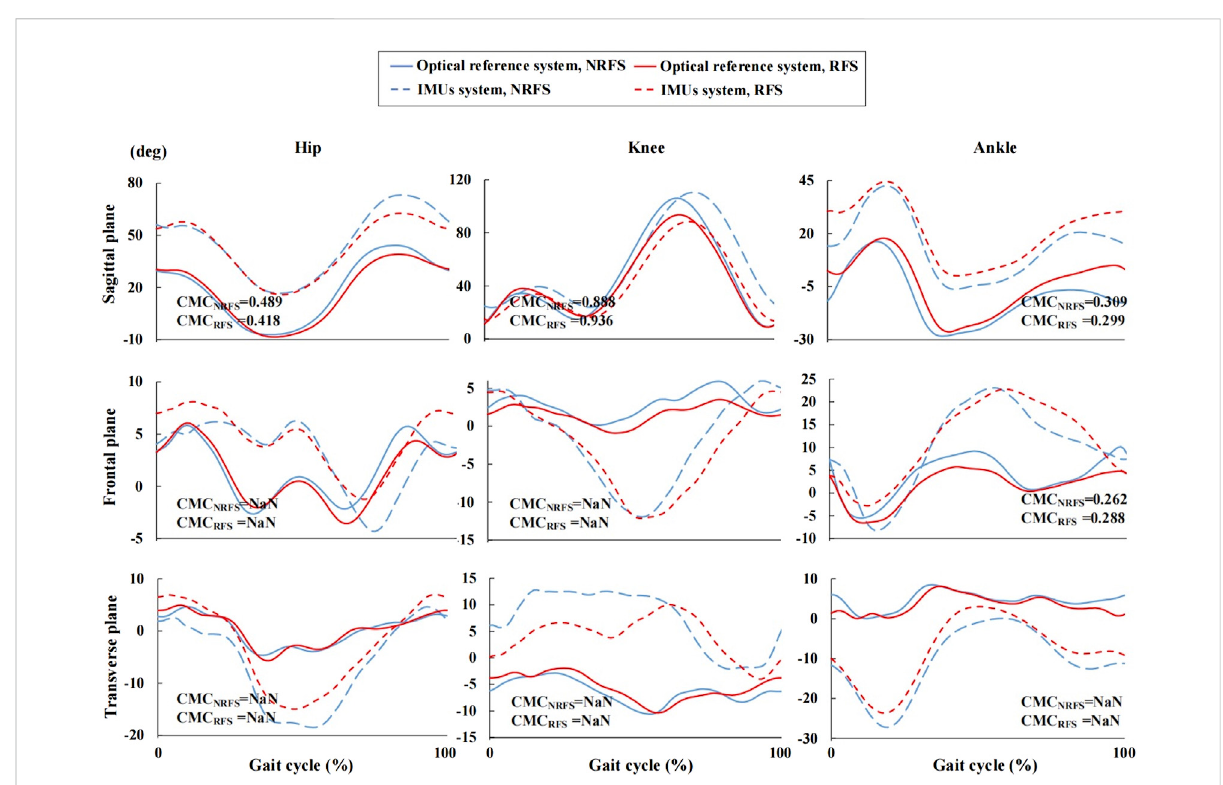
FIGURE 3 Joint angle waveforms during gait cycle measured by the inertial measurement units and optical reference system before offset